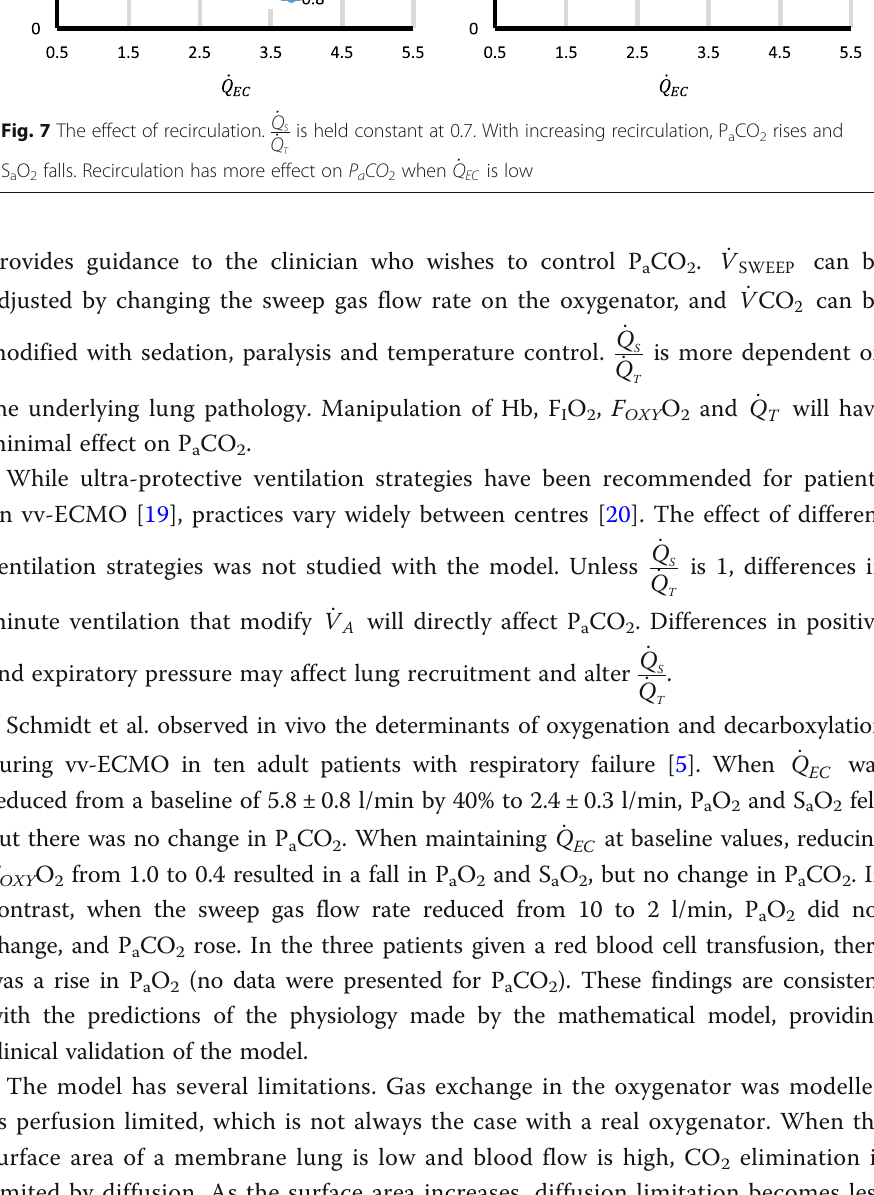
_ Q S _ is held constant at 0.7. With increasing recirculation, P a CO 2 rises and Q T